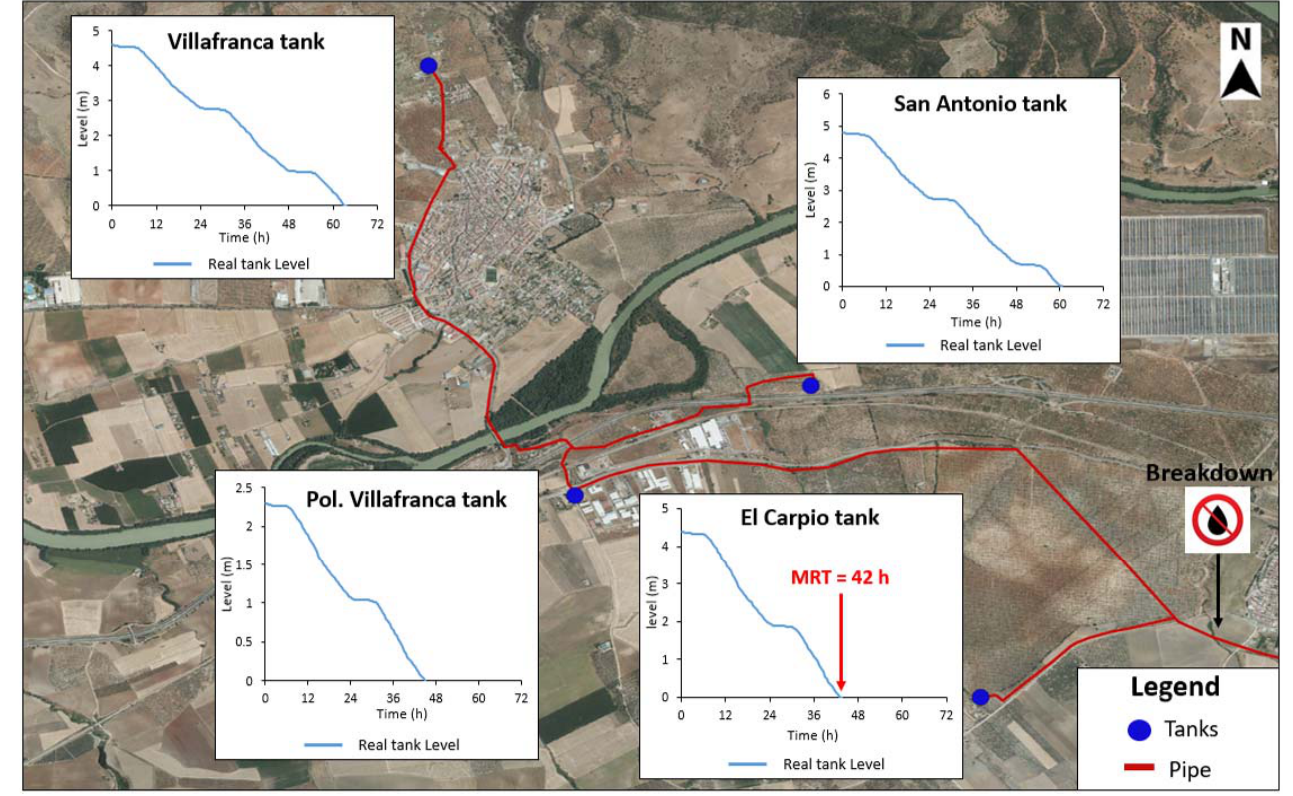
Figure 9. MRT estimation for the failure that occurred on 10 February 2020 in the studied